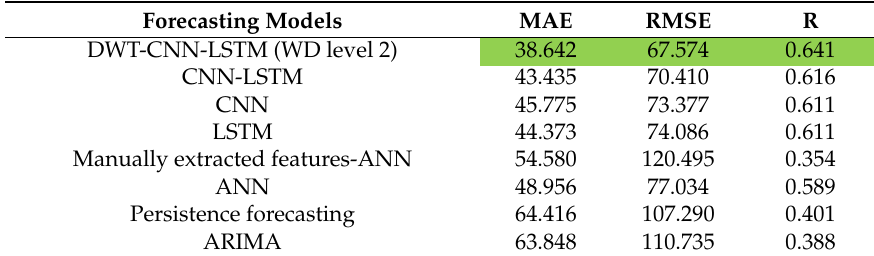
Table 14. The performance comparison of different heavy rainy days’ forecasting models using the dataset of Elizabeth City State University.